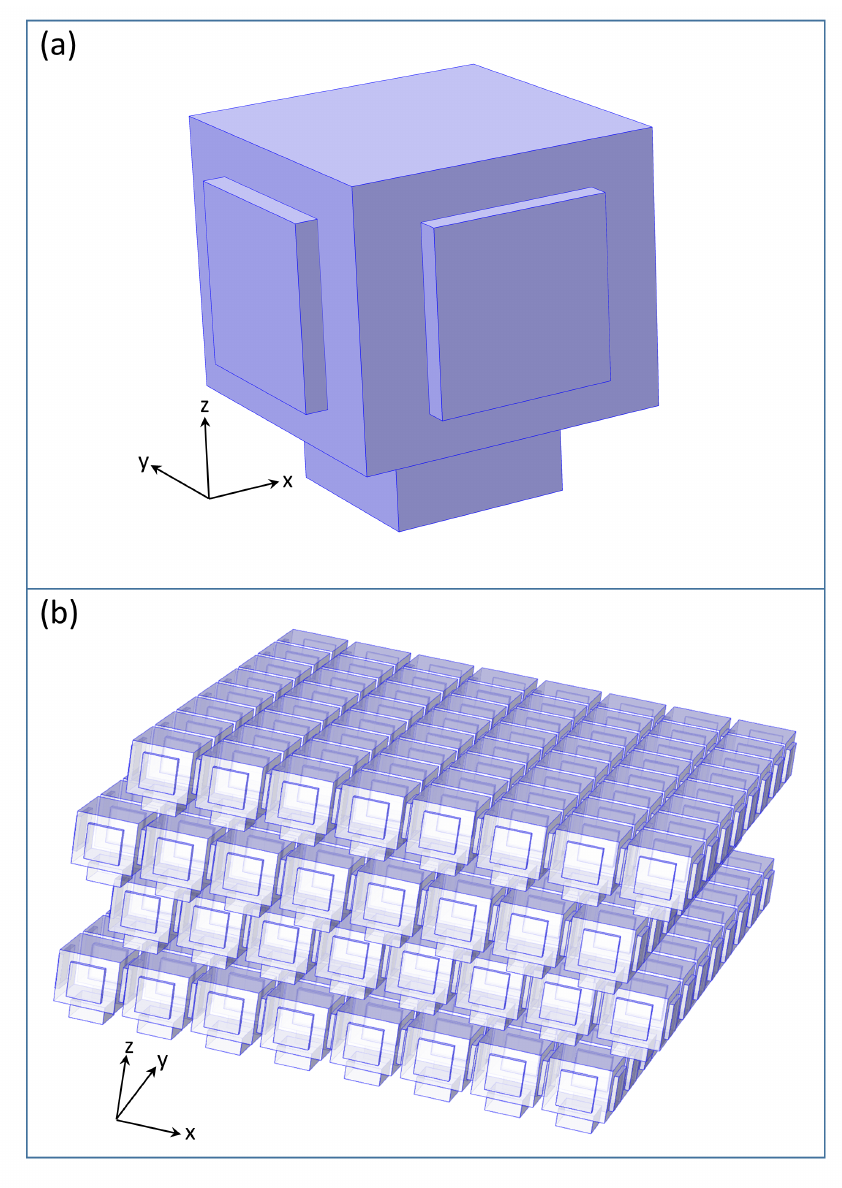
Figure 3. Network of the air voids in the photonic nanoarchitecture. ( a ) Unit cell, with a rectangular air void and horizontal and vertical channels. The real horizontal channels connecting the air voids are twice as long as that seen in this figure because the boundary plane of the unit cell cuts these channels in half. ( b ) The four-story structure built from 3D tiling of the space with the building block shown in Figure 3a. It is periodic in the xy directions and has four stories in the z direction. The adjacent stories are shifted by a half lattice constant in the x and y directions. An 8 × 8 cell section is shown in this figure; the real model structure is infinite in the x and y directions. The dimensions of the model are given in Figure 4 and Table 1. In the real structure, the spaces between the air voids are filled with chitin. x and y are the horizontal directions, and z is the vertical direction. The light is impinging from the upper ( − z )